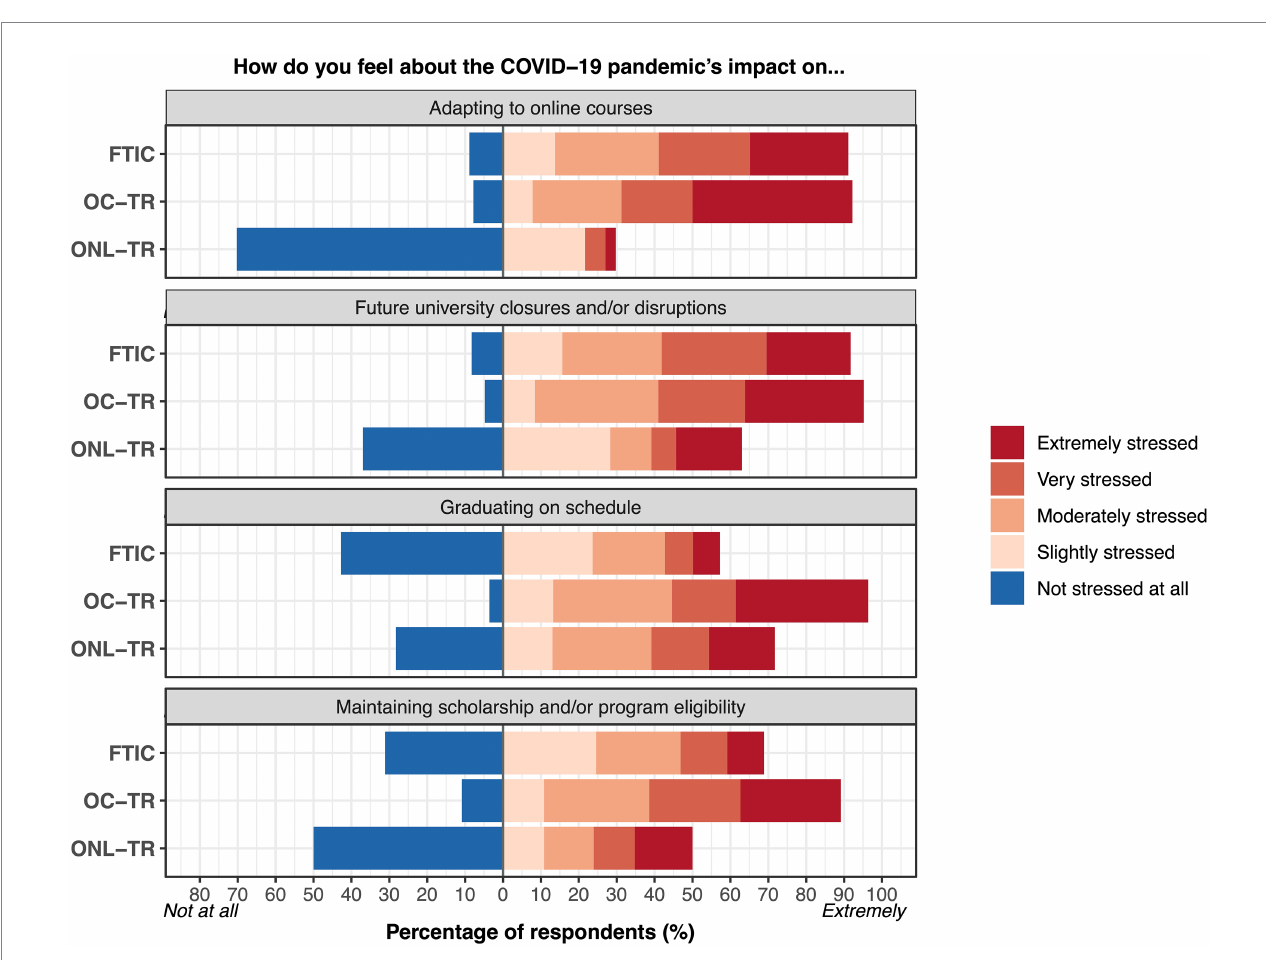
FIGURE 3 Online transfer students reported less stress related to academic disruptions during the pandemic. Percentage of responses based on a five-point Likert scale of level of stress to the pandemic’s impact on four academic stressors during the pandemic: adapting to online courses; future university closures/ disruptions; graduating on schedule; and maintaining scholarship and/or program